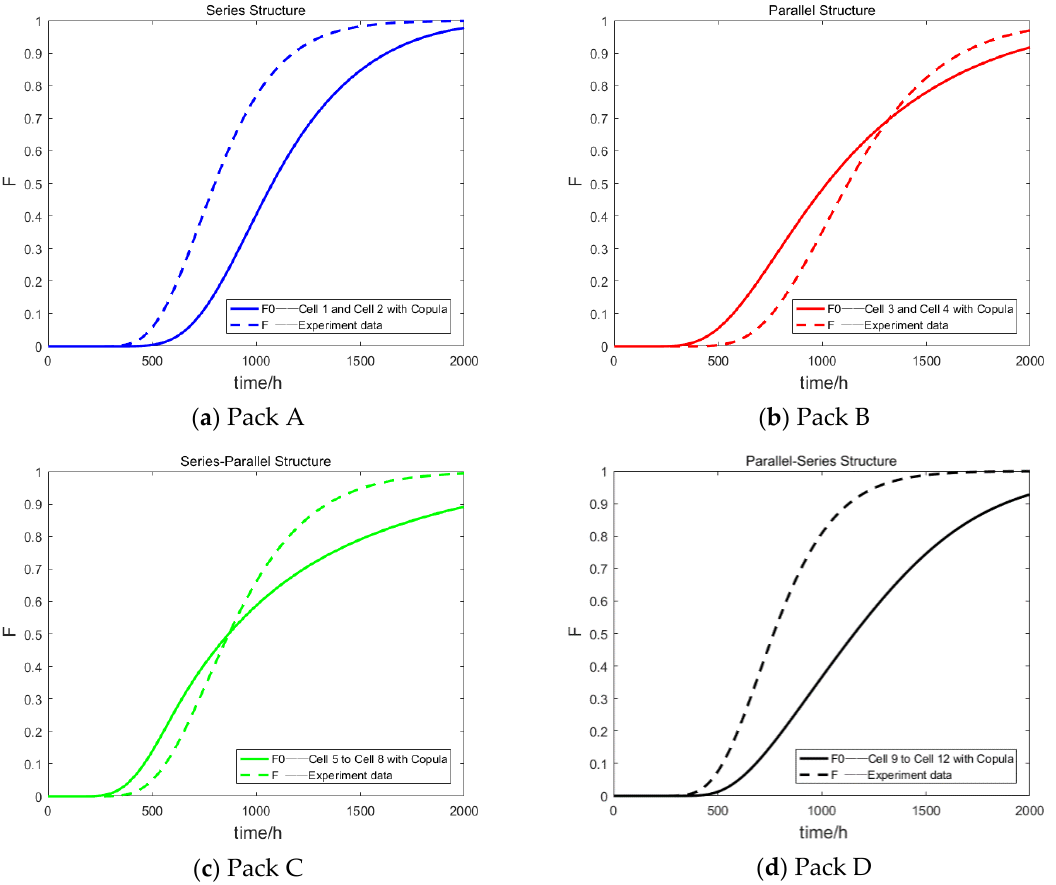
Figure 4. The dependency among individual batteries of four battery packs: ( a ) Pack A, (b ) Pack B, ( c ) Pack C, ( d ) Pack D.